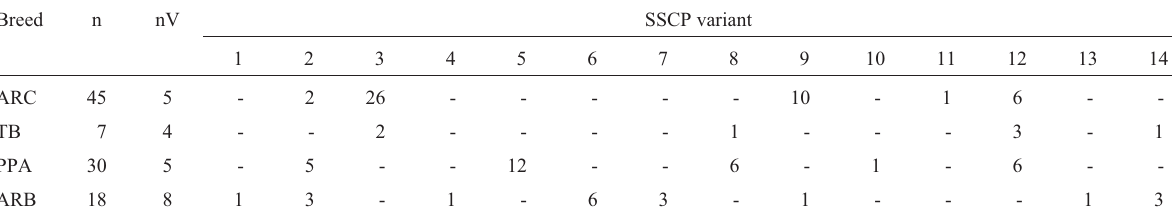
Table I - Number and type of SSCP variants detected in each horse breed. Breed n nV